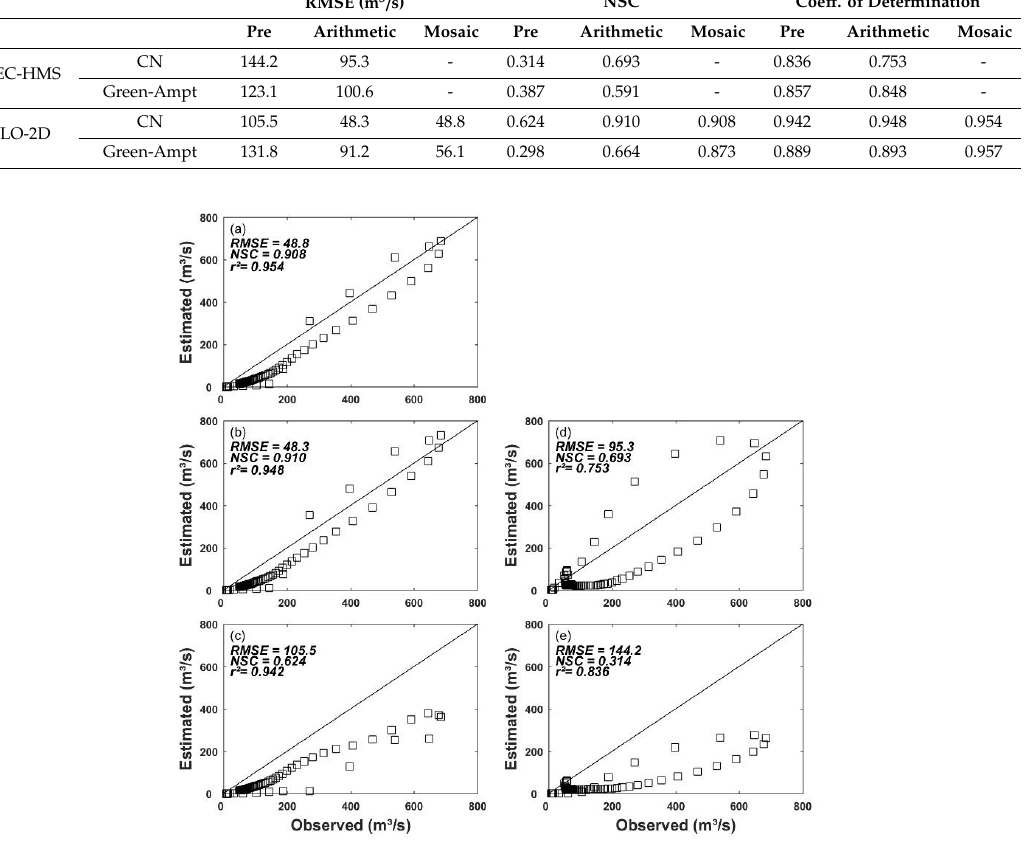
Figure 4. Observations versus simulations using the curve number method: ( a ) mosaic/FLO-2D, ( b ) arithmetic/FlO-2D, ( c ) predominant/FLO-2D, ( d ) arithmetic/HEC-HMS, and ( e ) predominant/HEC-HMS. Table 2. Basic statistics for each method simulated by both FLO-2D and HEC-HMS at Cheongmi station.